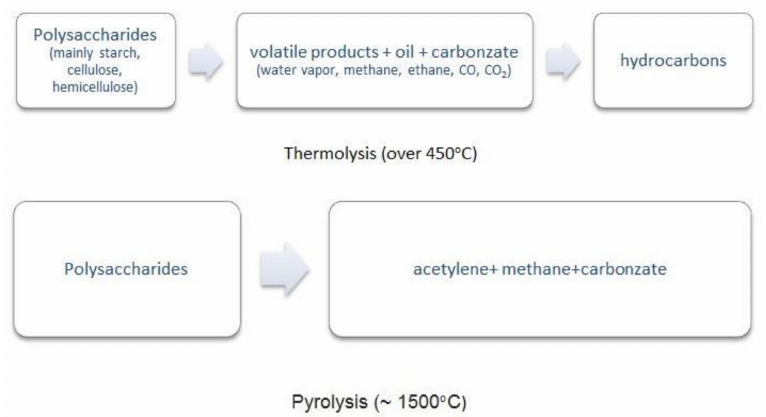
Figure 6. Fabrication of polysaccharides for non-food